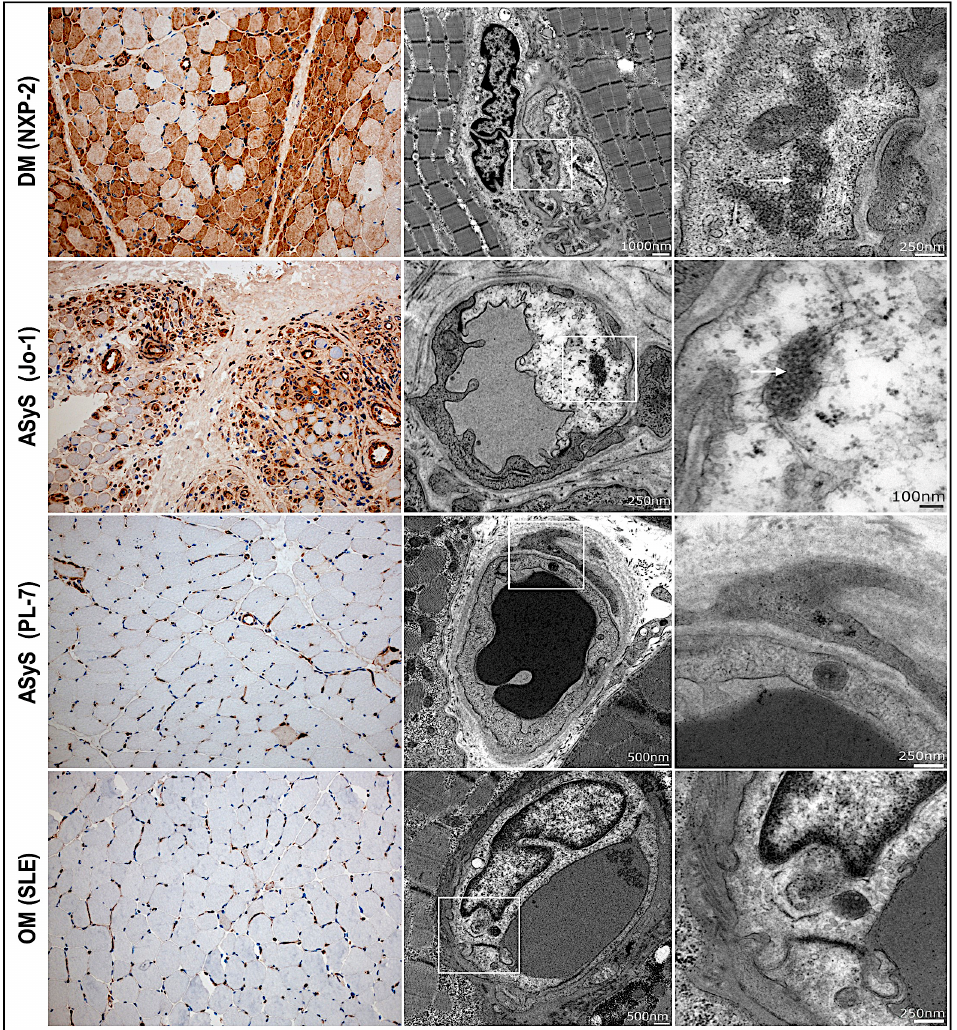
Figure 7. MxA upregulation and tubuloreticular inclusions in muscle biopsies from patients with IIM. Strong perifascicular upregulation of interferon surrogate marker MxA in DM (P4) and anti-Jo-1 ASyS (P14) associated with tubuloreticular inclusions (TIR) in the endothelial cells of small vessels. Weak MxA upregulation on scattered myofibers with nonspecific osmiophilic inclusions in anti-PL7 ASyS (P6) and OM (P3) (magnification 20 × ) (DM = dermatomyositis; ASyS = antisynthetase syndrome; OM = overlap